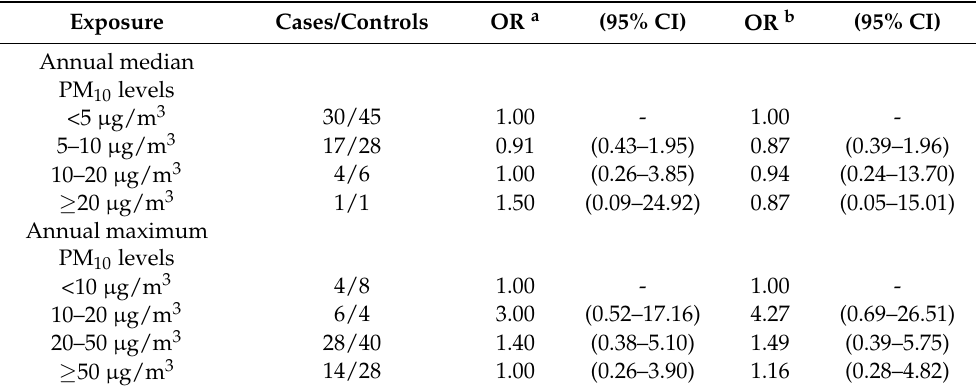
Table 2. Risk of amyotrophic lateral sclerosis according to particulate matter (PM 10 ) exposure using fixed cutpoints.